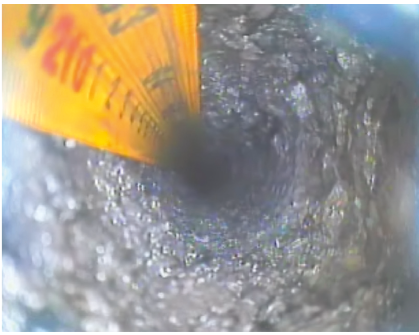
Figure 2: Broken surrounding